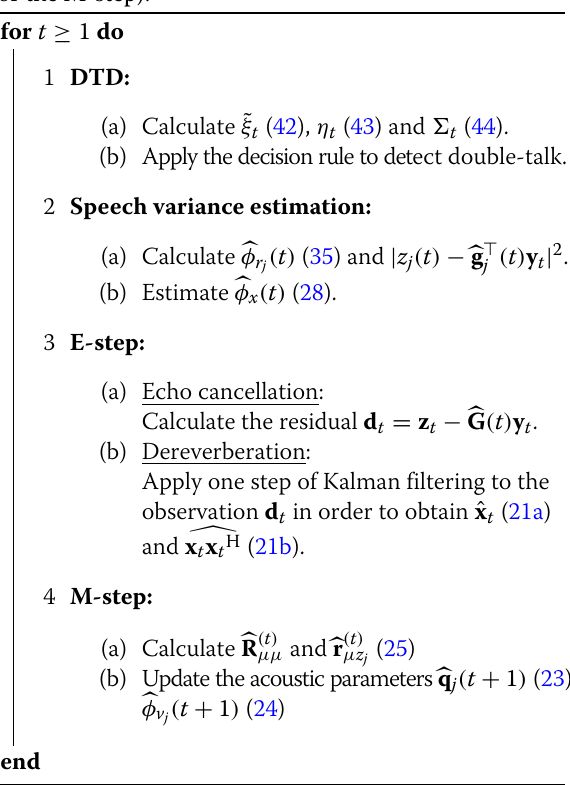
Algorithm 2: Kalman-EM algorithm for echo cancella- tion, dereverberation and noise reduction (RLS